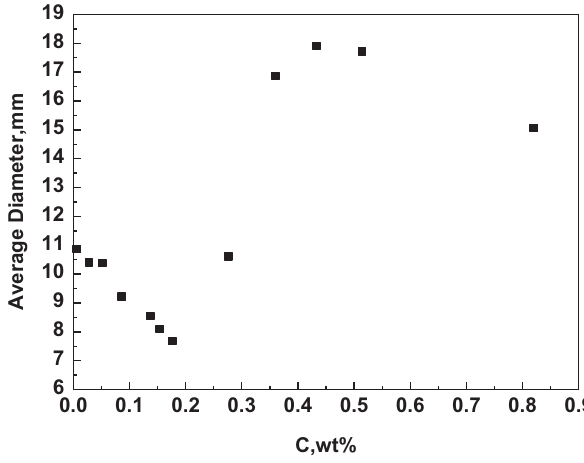
Figure10: Affect of carbon content on the average bottom diameter of solidified